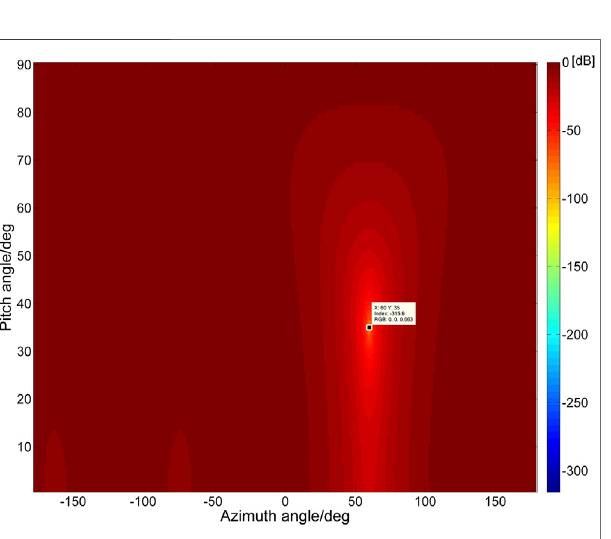
FIGURE 11 | The beam pattern of the antenna